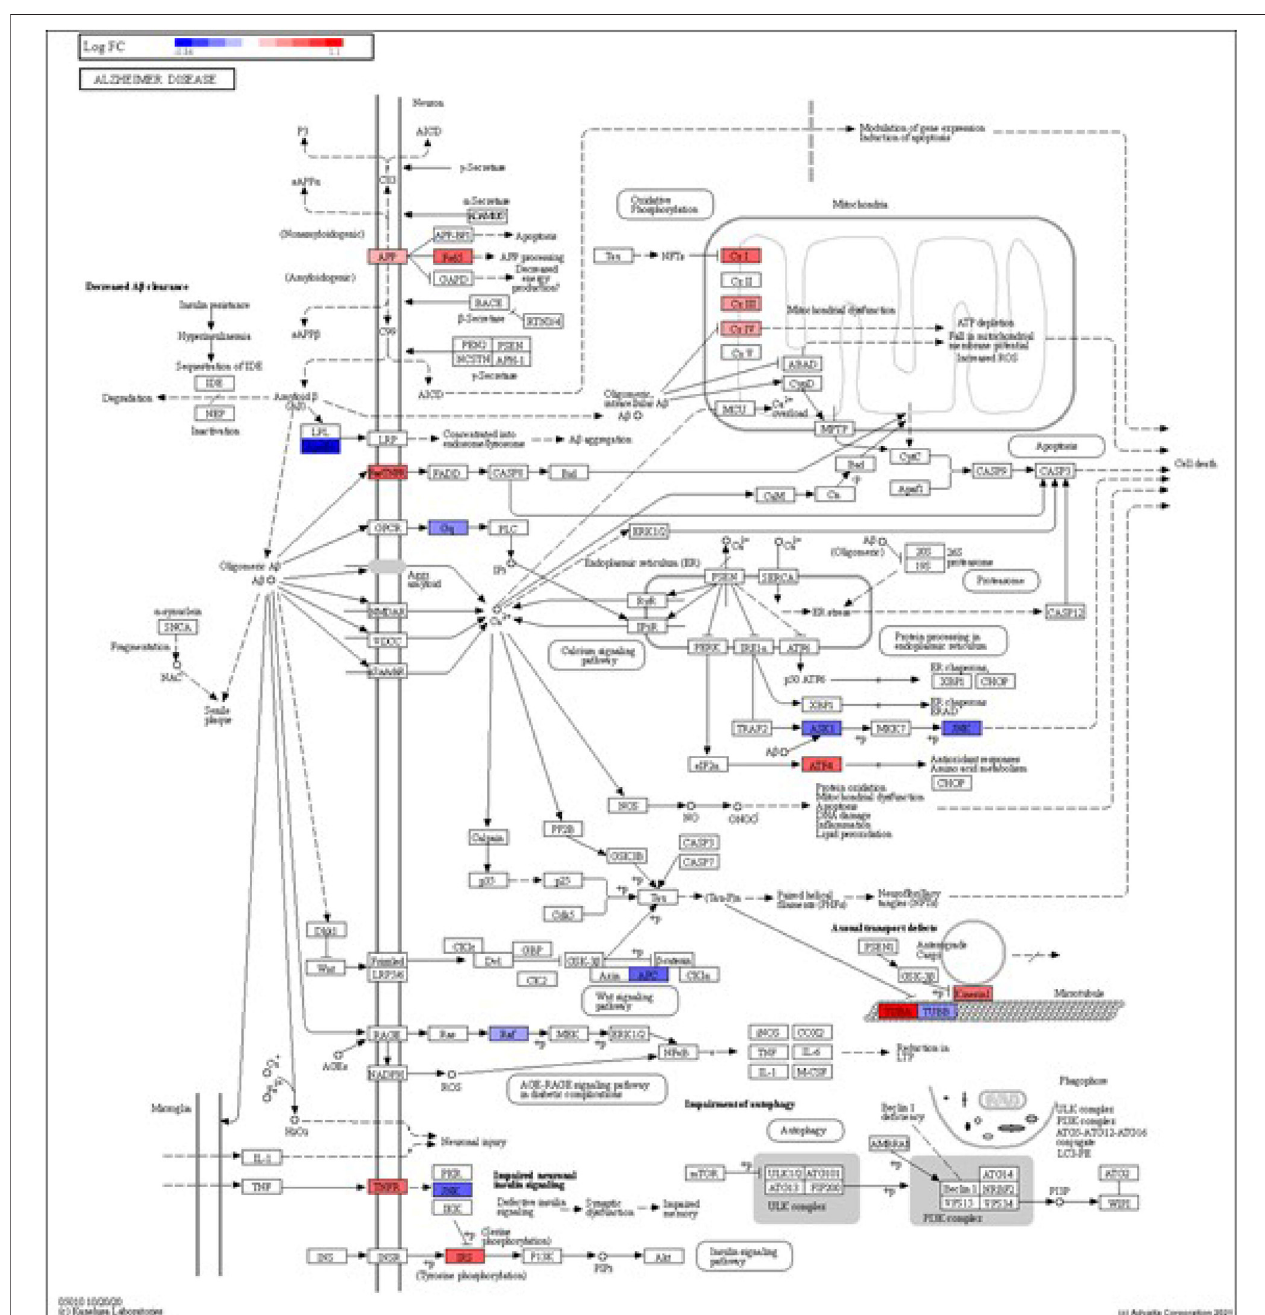
FIGURE3| iPathwayGuideanalysisshowsthedifferentiallyregulatedgenesintheKEGGAlzheimer ’ sdiseasepathwayinastrocytesfromtheADgroup(AD00203) compared to astrocytes from the healthy control group (AD00201).